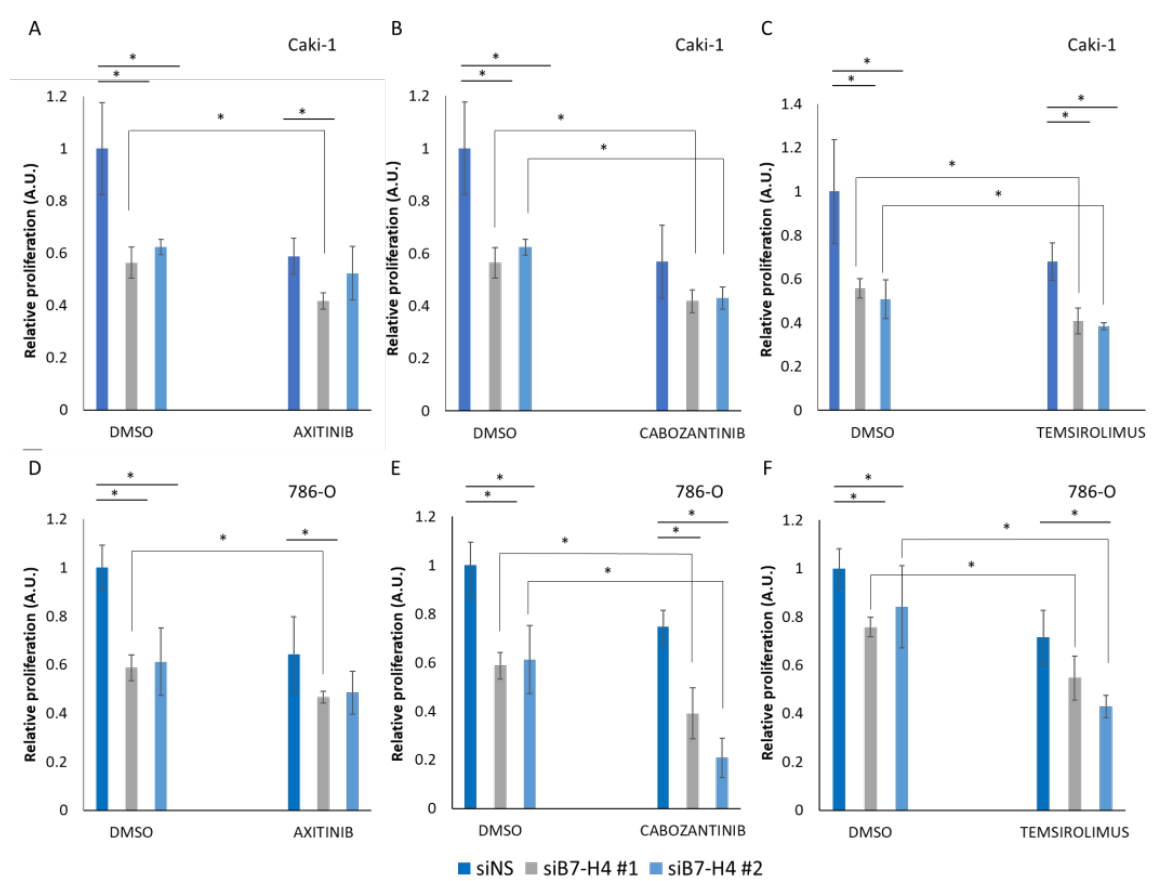
Figure 5. Proliferation analysis of Caki-1 and 786-O renal cancer cells after B7-H4 silencing and treatment with tyrosine kinase and mTOR inhibitors. MTS assay was used to measure proliferation of siB7-H4 Caki-1 ( A – C ) and 786-O ( D – F ) cells after 72 h of treatment with vehicle (DMSO), 20 µ M Axitinib ( A , D ), 8 µ M Cabozantinib ( B , E ), or 0.1 µ M Temsirolimus ( C , F ). Data are shown as relative proliferation ±S.D. Statistically significant results ( p < 0.05) are marked with *. All data were normalized relative to untreated siNS cells and are shown in arbitrary units (A.U.).